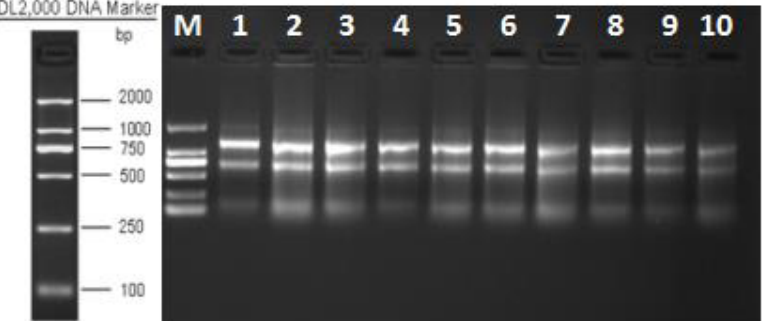
Figure 1. Determination of total RNA